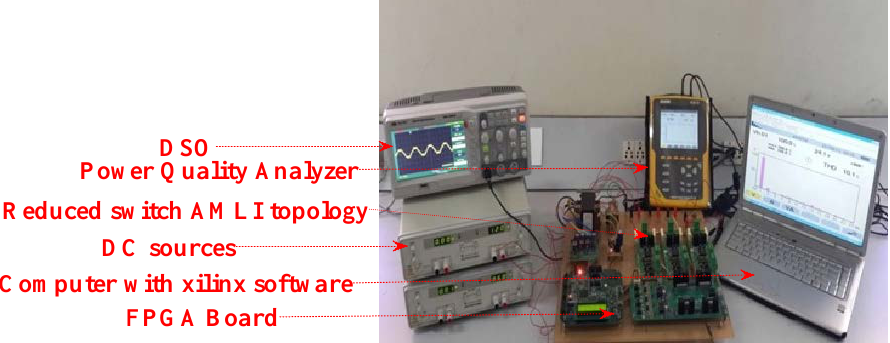
Figure 16. Laboratory-based experimental setup for asymmetric reduced switch multilevel inverter.